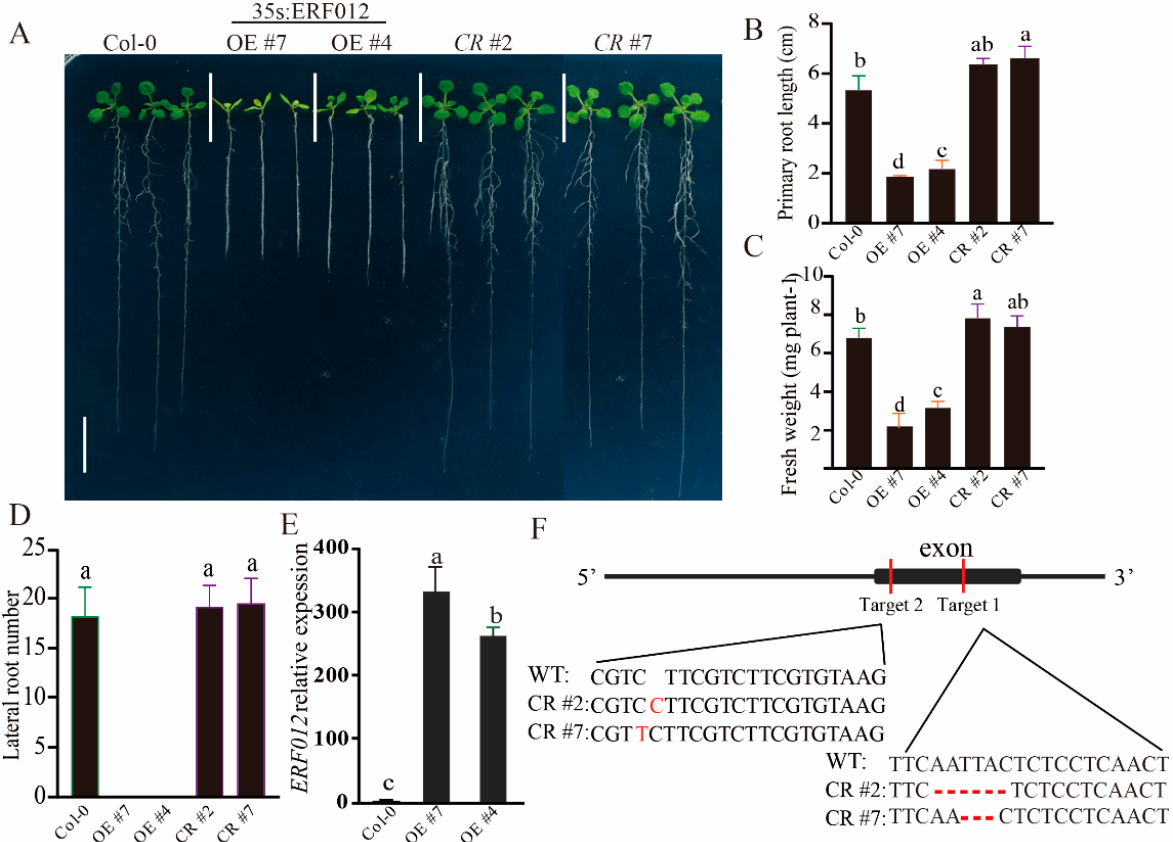
Figure 2. ERF012 regulates plant growth and development. ( A ) Phenotypical comparison of Col-0, ERF012 overexpression in plants and erf012 mutants. Twelve-day-old seedlings grown on 1/2 MS solid medium were imaged, scale bar = 1 cm. ( B – D ) The primary root length, shoot fresh weight and the lateral root number were statistically measured in ( A ), n = 18 plants. ( E ) Validation of ERF012 -OE plants by qRT-PCR analysis; n = 3 pools, with about 20 plant roots per pool. ( F ) Mutation information of ERF012 in its exon sequence established by a CRISPR/Cas9 system. Letters in ( B – E ) indicate significant differences between different plants: Duncan’s test ( p < 0.05).